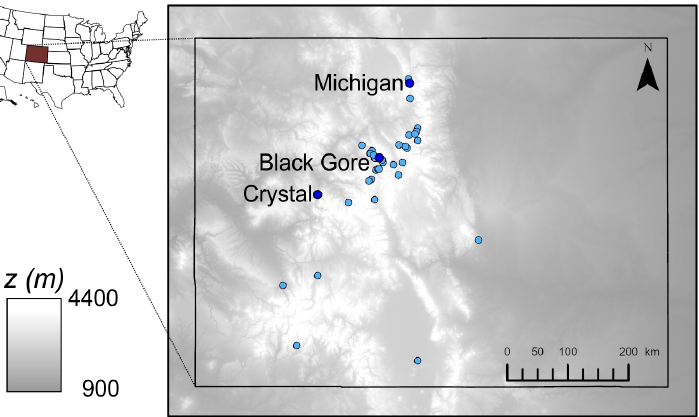
Figure A1. A site map illustrating the state of Colorado within the USA and an elevation map of Colorado with the 40 study watersheds and the three focus watersheds (Black Gore Creek, Crystal River, and Michigan